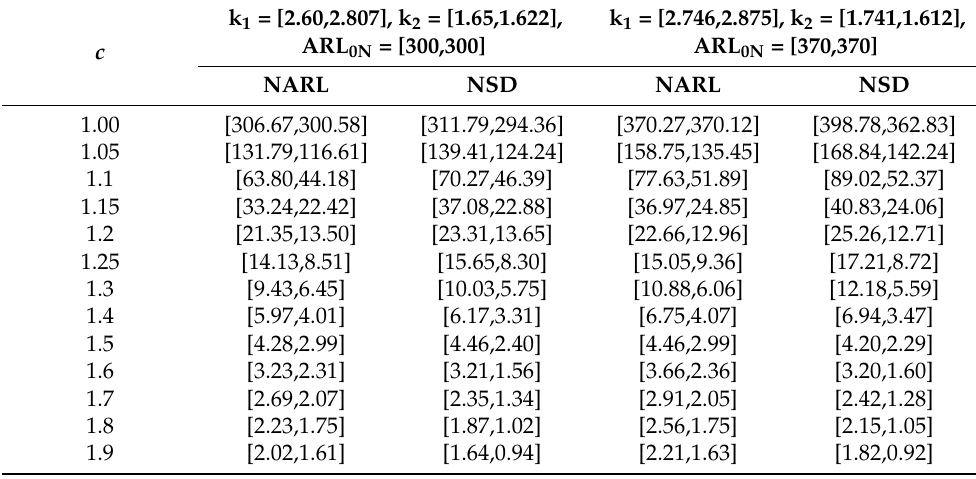
Table 1. The NARL when n N (cid:101) [3,5] and I λ U = 0.3.